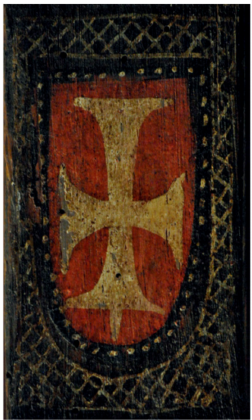
Figure 9. The shield and cross patty and fiched on one of the beams, of the 13th century, which had been in the Bishop’s